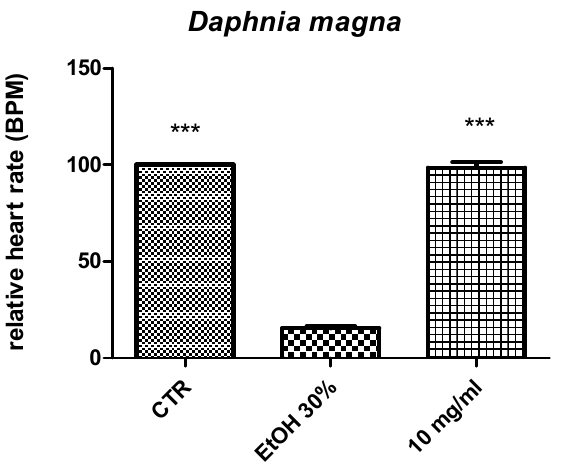
Figure 2. Effects induced by grape pomace water extract (10 mg/mL) on hearth rate in the Daphnia magna toxicity model. ANOVA, p < 0.0001; *** p < 0.001 vs. EtOH 30%, this last representing the positive control toxicity group.